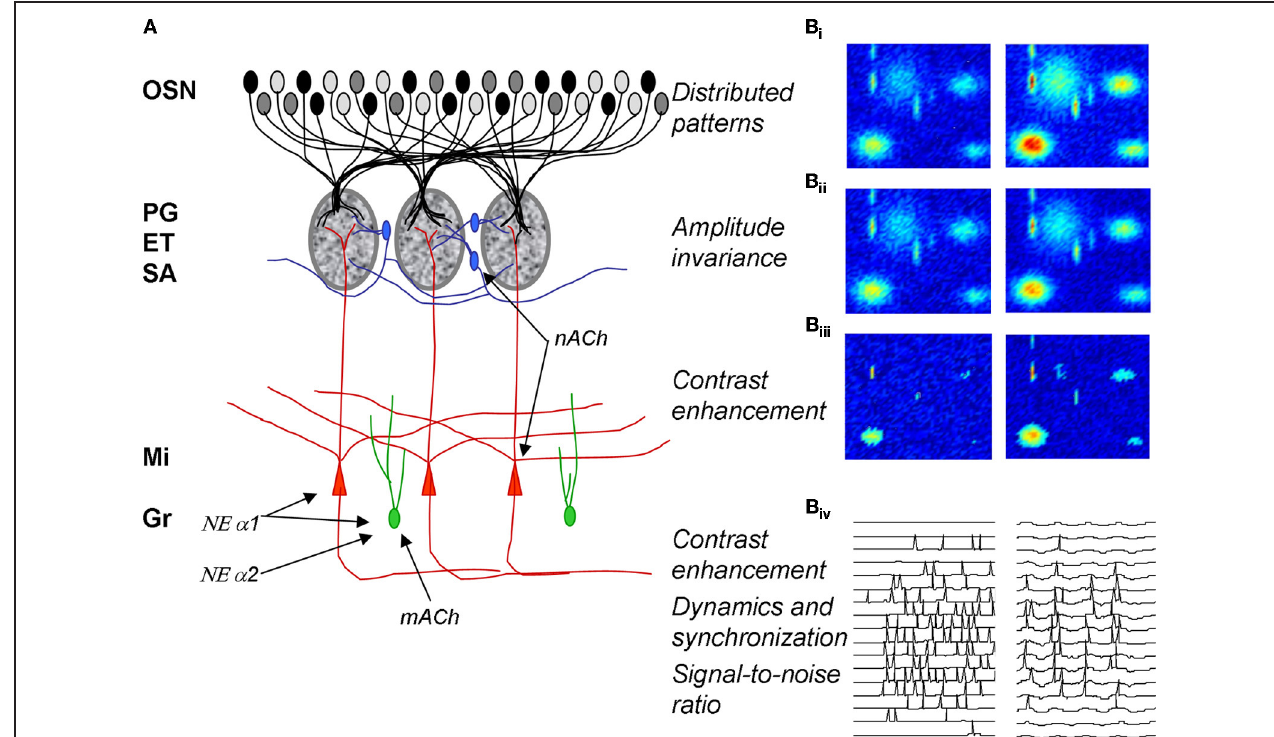
FIGURE 1 | Olfactory bulb processing. (A) Schematic of olfactory bulb organization. Olfactory sensory neurons (OSN) expressing a common receptor and therefore exhibiting similar odor receptive fields project to common glomeruli in the olfactory bulb (MOB). Within this glomerulus, OSNs make excitatory synapses onto mitral and tufted cells, the primary output neurons of the MOB, as well as glomerular layer interneurons comprising periglomerular (PG) and external tufted (ET) cells. Most PG cells ( ∼ 70%), and a third type of interneuron, short axon cells (SA), are not directly activated by OSNs. PG, ET, and SA cells form intricate networks within the glomerular layer that have been proposed to perform operations such as normalization, contrast enhancement and synchronization. In deeper processing layers mitral cells (Mi) interact with at least one other class of interneurons, granule cells (Gr). These provide extensive feedback and lateral interactions between mitral cells by interacting with their elongated secondary dendrites. This layer of processing is thought to be involved in creating olfactory bulb oscillatory rhythms and generating synchronized spike patterns. Noradrenergic inputs from the locus coeruleus activate three classes of noradrenergic receptors distributed across the MOB. NE α 1 receptors are thought to be predominantly located on Mi and Gr cell bodies as well as secondary dendrites with a sparser distribution in the glomerular layers; NE α 2 receptors